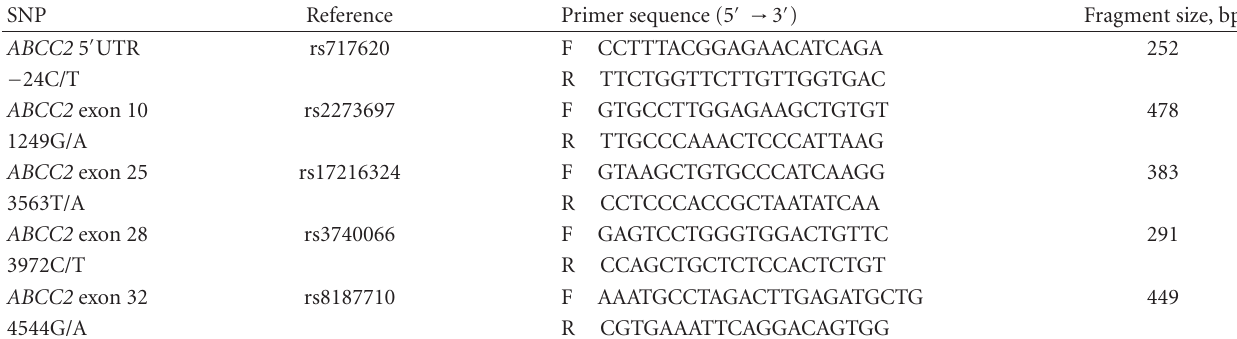
Table 1: Primers used for genotyping ABCC2 (MRP2) polymorphisms.